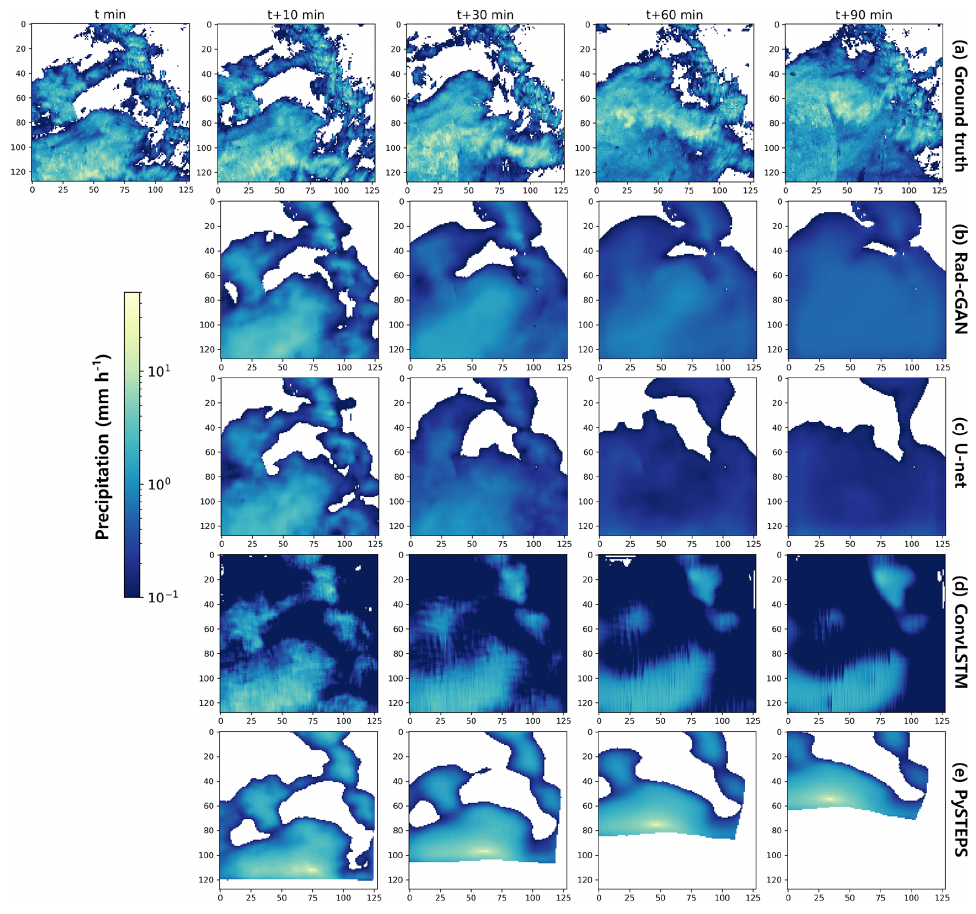
Figure 5. Example of precipitation at forecasting time t = 23 August 2018, 17:50UTC, for model predictions and ground truth (observation). Panels from top to bottom express (a) ground truth, (b) prediction of Rad-cGAN, (c) prediction of U-net, (d) prediction of ConvLSTM, and (e) prediction of pySTEPS.